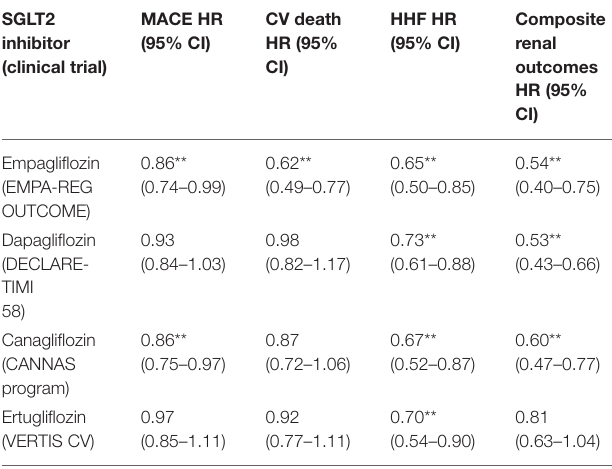
TABLE 2 | Cardiorenal outcomes of SGLT2